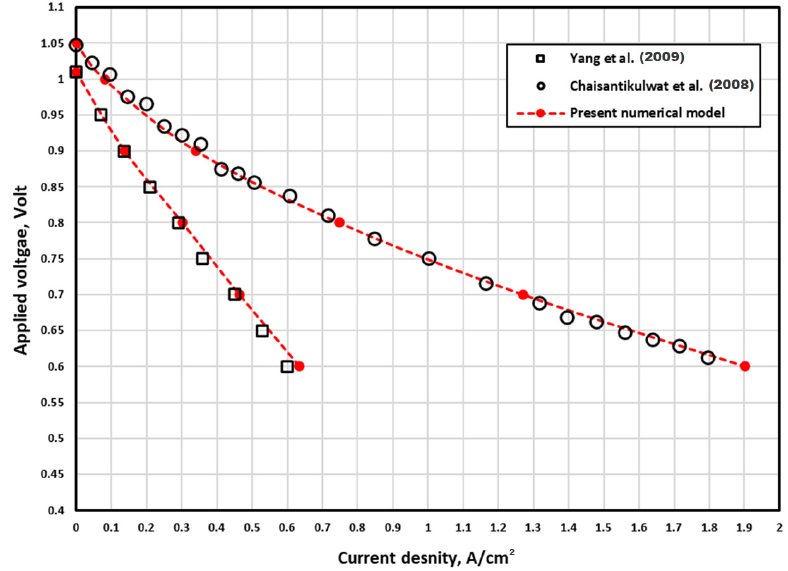
Figure 5. Validation of the numerical result with the experimental result.